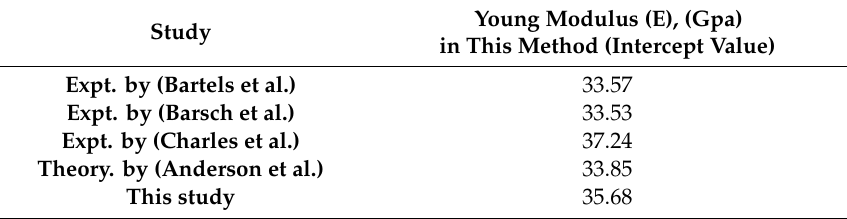
Figure 8. Young’s modulus of each plane of NaCl extracted by XRD patterns versus planar density. Table 4. Young’s modulus values of NaCl.